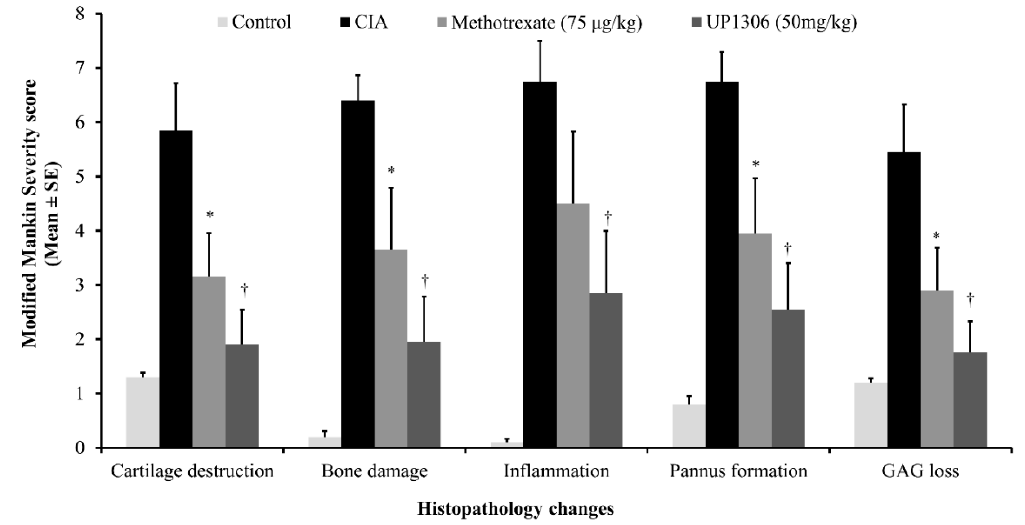
Figure 11. Histopathology findings of rats’ ankle joint treated with UP1306 in CIA model. Cartilage destruction (0–6): Cartilage thickness/thinning, irregular surface frayed/fissure loss, degeneration,